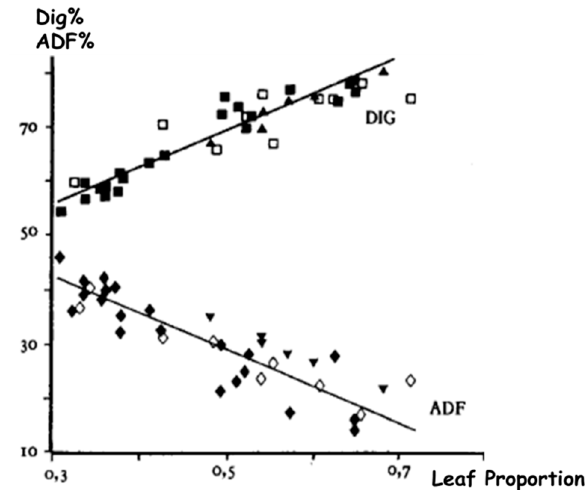
Figure 6. Relationship between forage digestibility (%D) or ADF concentration (ADF%) with the proportion of leaves in the forage mass (W L /W) for alfalfa (same conditions as for Figure 2). Data obtained at Lusignan (46.46° N; 0.07° E), France, and redrawn from Lemaire et al. [30].